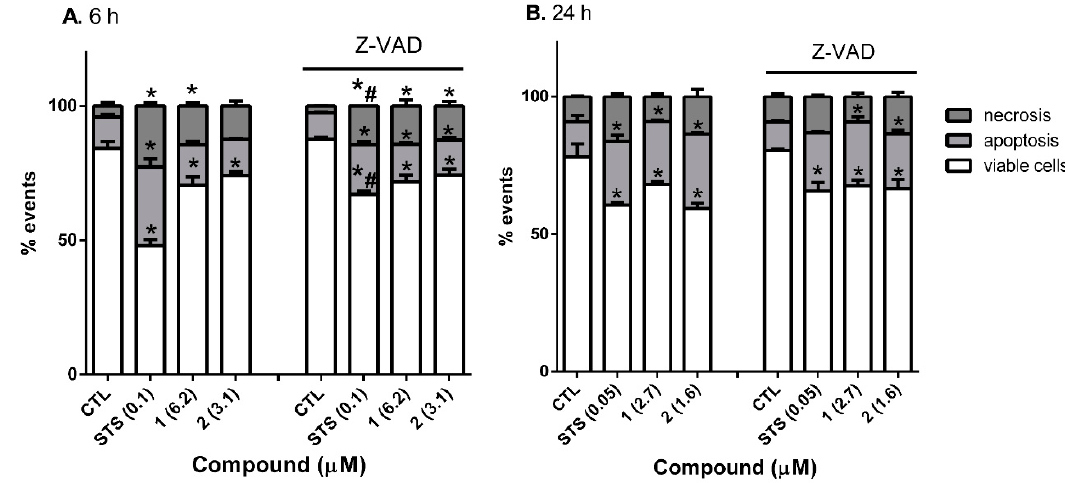
Figure 4. Determination of cell death type produced by 1 and 2 on SH-SY5Y cells. Human neuroblastoma cells were treated with compounds for 6 ( A ) and 24 h ( B ) with and without pre-incubation with 40 µM Z-VAD. Staurosporine (STS) was used as a positive control. Cell death type was determined with Annexin V-FITC/PI staining by flow cytometry. Values are mean ± SEM of three independent replicates expressed as a percentage of untreated control cells. Statistical differences were determined by Student’s t test. * p < 0.05, comparison of compound treatment and control cells. # p < 0.05, comparison between treatments with compounds alone and co-treatment with compounds and Z-VAD.